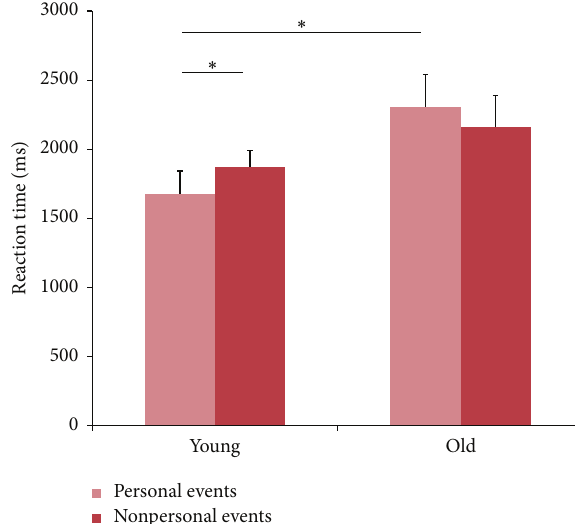
Figure 2: Group × Event interaction on RTs. Values are in ms and error bars depicted SEM. Asterisks indicate significant differences ( 𝑝 < 0.05 ).